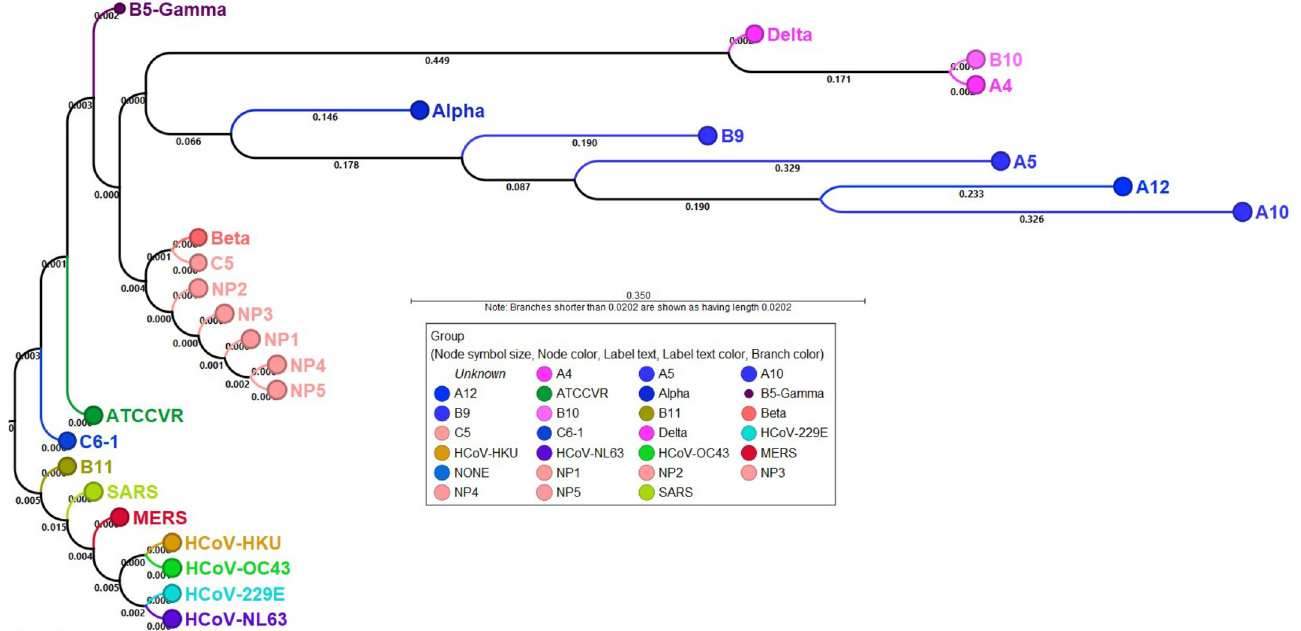
Fig 5. Phylogenetic analysis on study specimens. A maximum likelihood tree was constructed to explore the phylogenetic relationship between SARS-CoV-2, SARS-CoV-1, MERS and endemic coronaviruses (HCoV-NL63, HCoV-229E, HCoV-OC43, HCoV-HKU). The whole genome sequences for SARS, MERS and endemic coronaviruses were downloaded from NCBI. The numbers along the branches mark the bootstrap values percentage out of 1000 bootstrap resamplings. Samples NP1-NP5 that represent sampling from Jan-Feb 2021 form a clade and are highlighted with pink color. ATCCVR RNA shown in green font color and C6 and B11 patient sample are part of separate clade. Sample B9, A5, A12, and A10 shown in blue label font color cluster closely on tree. Dots labels as Alpha, Beta and Delta represent reference genomes for respective strains downloaded from NCBI.